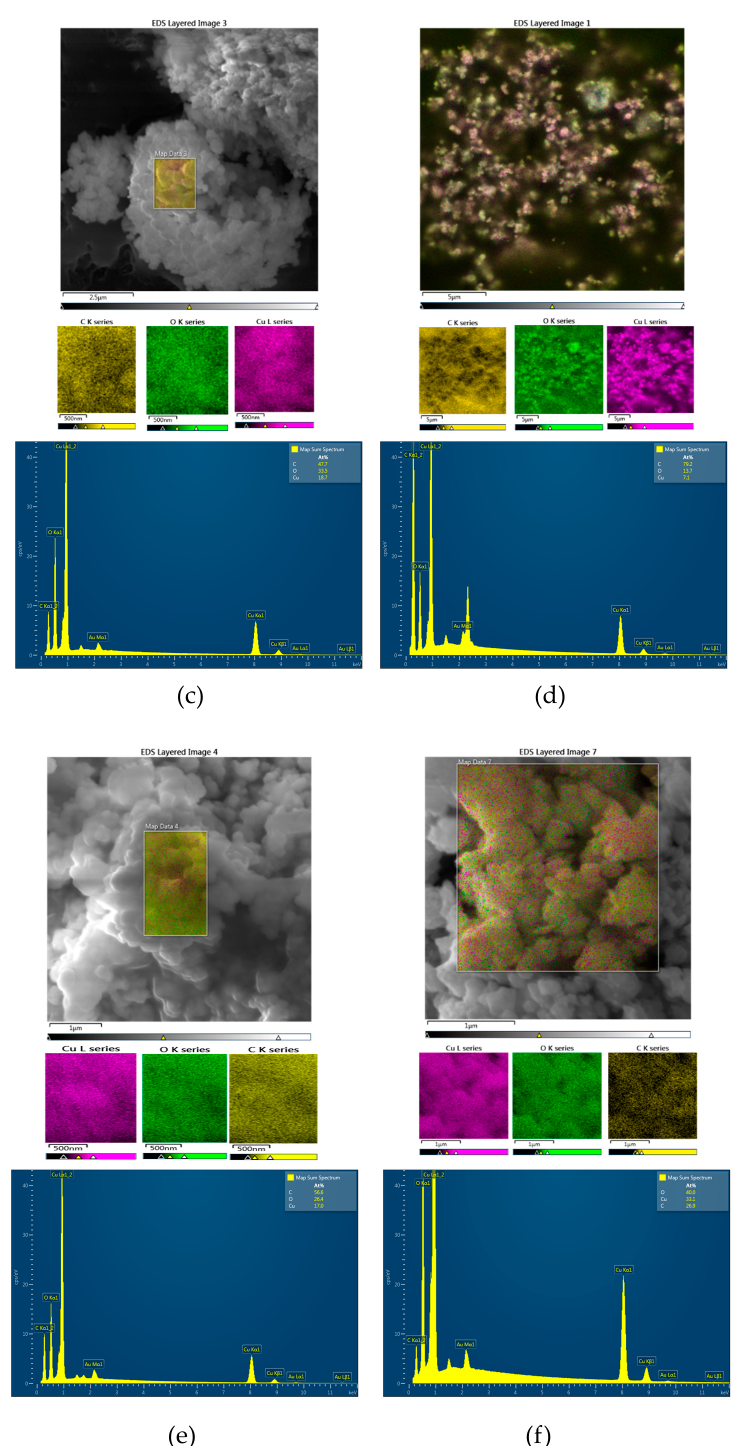
Figure 2. Surface elemental mapping of gold-coated ( a ) powder Cu 2 ONPs; ( b ) Cu 2 ONPs immobilized onto LLDPE by extrusion; ( c ) Cu 2 ONPs immobilized onto LLDPE using ethyl cyanoacrylate; ( d ) Cu 2 ONPs immobilized onto LLDPE using epoxy resin; ( e ) Cu 2 ONPs immobilized onto LLDPE using trimethoxyvinylsilane; ( f ) Cu 2 ONPs immobilized onto LLDPE by thermal adhesion. Each sample is characterized by an energy dispersive X-ray spectroscopy (EDS) layered image (upper panel) with individual elemental mapping showing oxygen as green, copper as purple, and carbon as yellow (middle panel), and EDS spectrum (bottom